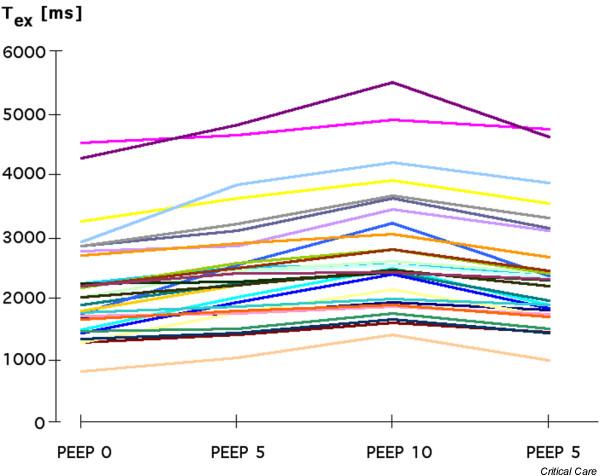
Short-term effects of PEEP on expiratory time in the individual patient. Results are from the investigation with PEEP steps of 30 s duration, and each coloured line shows findings for a different patient. Although Tex is dispersed over a wide range, its behaviour was similar between patients (i.e. Tex increased with the increasing levels of PEEP, and vice versa). PEEP, positive end-expiratory pressure; Tex, expiratory time.